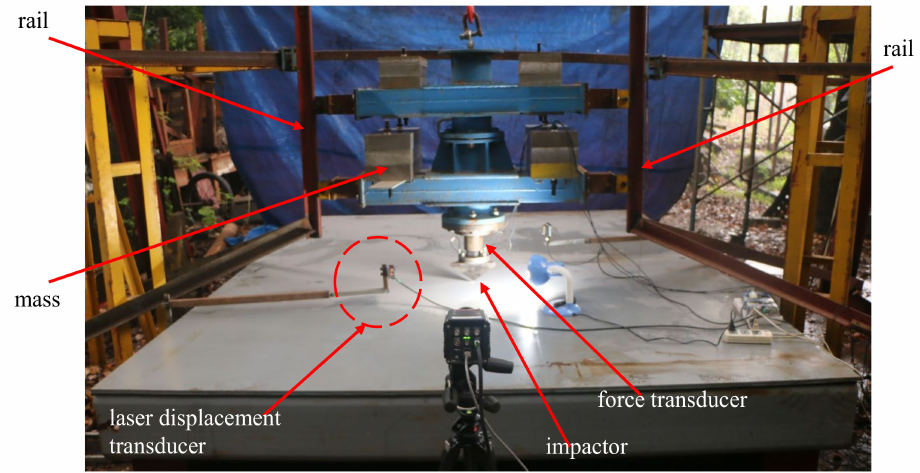
Figure 4. Weight drop impact test